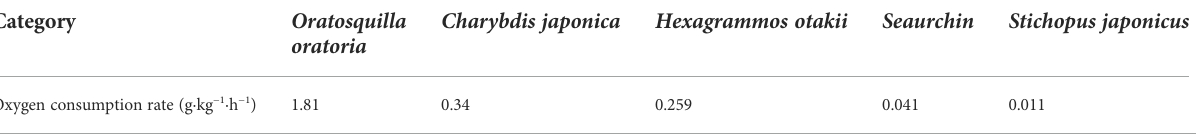
TABLE 3 Oxygen consumption rate of marine organisms invoked from recent studies (e.g., Xu, 2014; Yu et al., 2017; Hu et al., 2021).